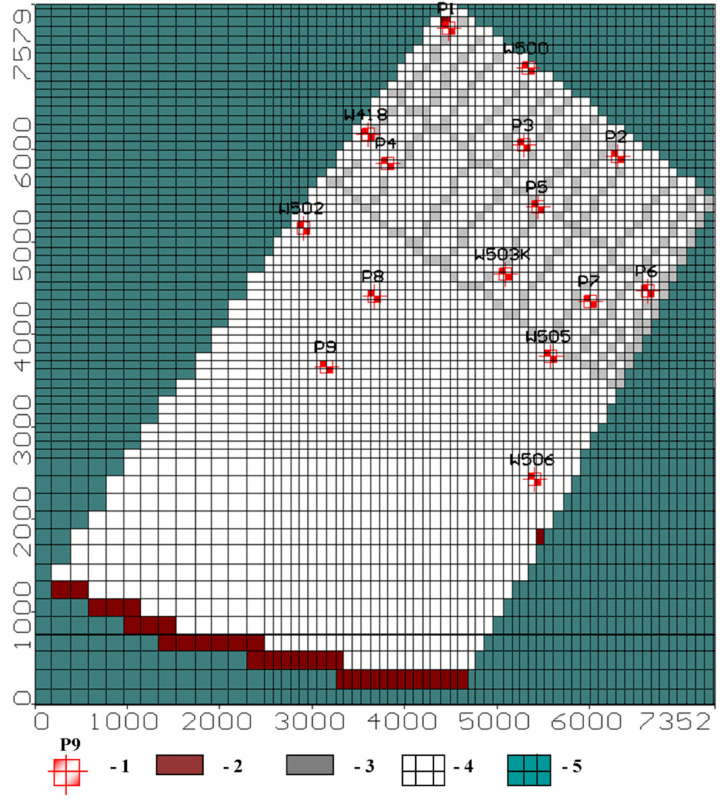
Figure 4. The Shengeldy irrigation area experimental site: model grid and boundary conditions. The legend numbers indicate the following locations on the map: 1 = observation well; 2 = boundary condition, first type; 3 = existing drains; 4 = active cells; 5 = inactive cells (no flow within the model